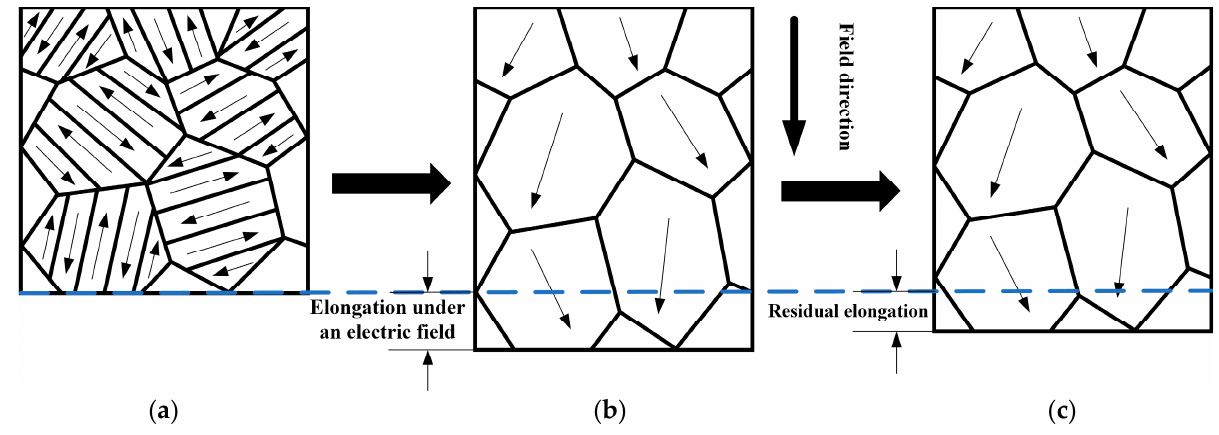
Figure 3. Schematic diagram of the change of electric domains in piezoelectric ceramics during the polarization process: ( a ) before polarization; ( b ) during polarization; ( c ) after polarization.